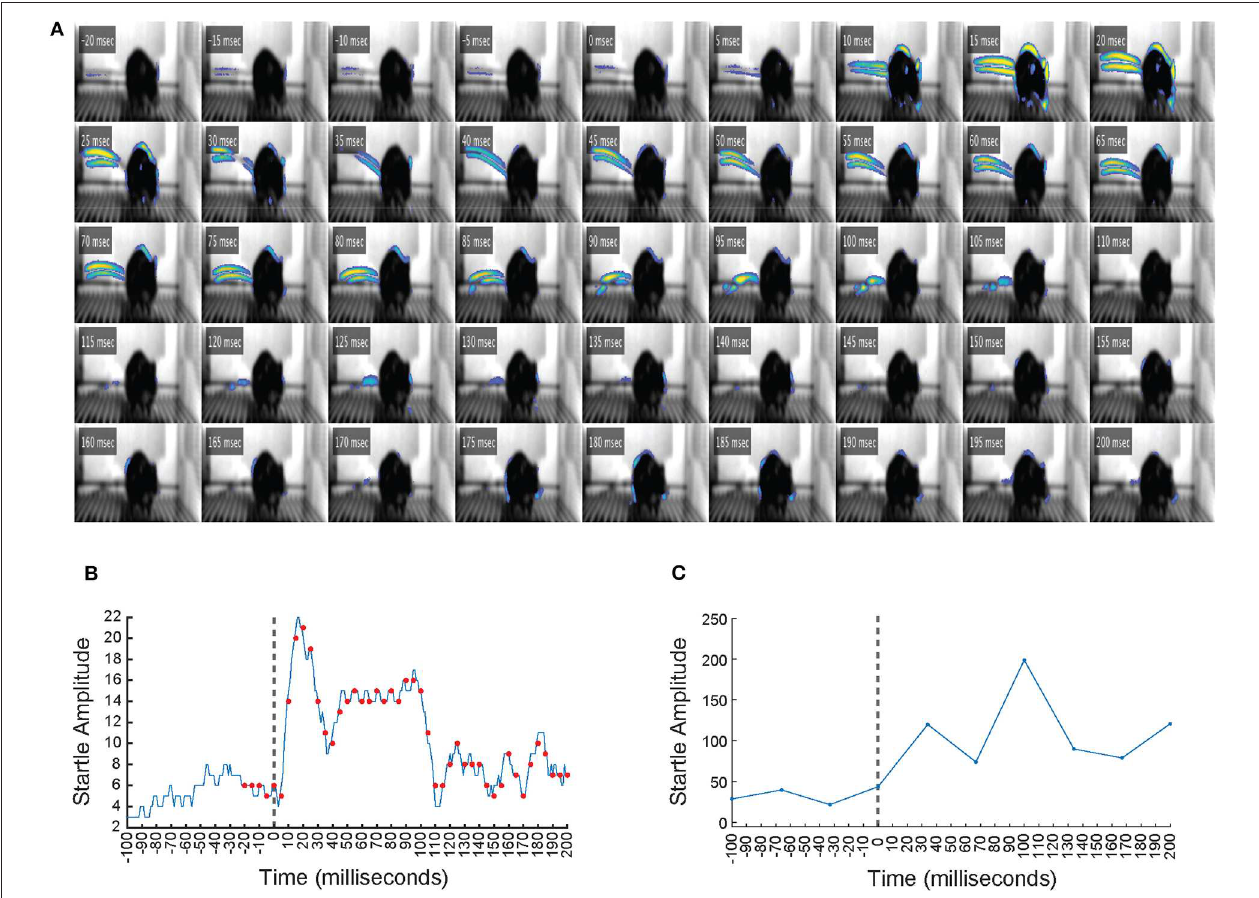
FIGURE 3 | The startle response as captured by a high-speed imaging system. (A) Frame-by-frame video still images showing a mouse from 20ms before to 200ms after the onset of a 105 dB, 200ms white noise burst. Digital video was recorded at 1,000Hz, so each frame represents 1ms of video. Time (t) indicated is relative to the onset of the noise burst ( t = 0ms). Animal motion is represented by pseudocoloring of the pixels, such that brighter colors indicate more movement in that region. The startle response was observed from t = 5ms to t = 105ms and was characterized by significant nose, ear, back, and tail movements that progressed from rostral to caudal. (B) The motion index calculated from the high-speed video of every 1ms from 100ms before to 200ms after the onset of the noise burst. Vertical dashed line indicates the onset of the white noise burst at t = 0ms. Red dots represent the time points of the video frames displayed in (A) . Startle amplitude showed a large increase between t = 0ms and t = 200ms. (C) The motion index calculated by VideoFreeze of every 33.33ms from 100ms before to 200ms after the onset of the noise burst. Vertical dashed line indicates the onset of the white noise burst at t = 0ms. Startle amplitude showed a large increase between t = 0ms and t = 200ms.